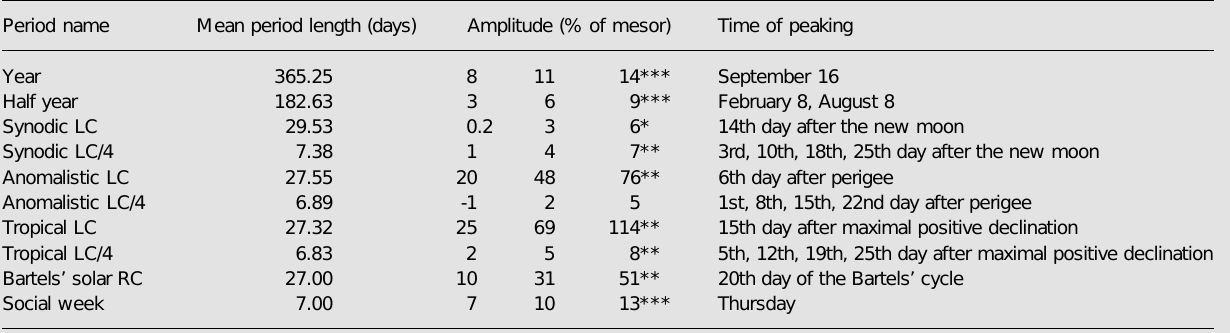
Table 2. Chronobiometric parameters of Passo Fundo, Brazil birth data.